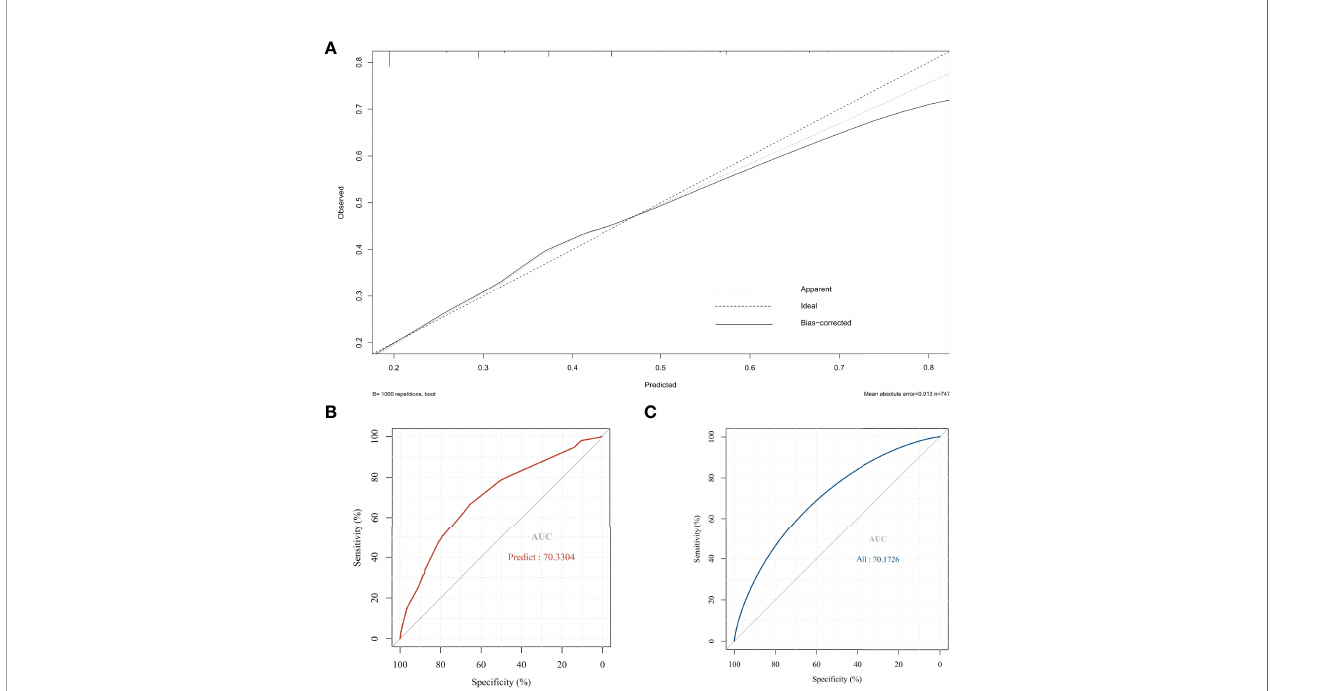
FIGURE 3 | (A) The calibration curve for evaluating the accuracy of the nomogram; (B) The receiver operating characteristics (ROC) curve and area under the ROC curve (AUC) in the training cohort; (C) The receiver operating characteristics (ROC) curve and area under the ROC curve (AUC) in the validating